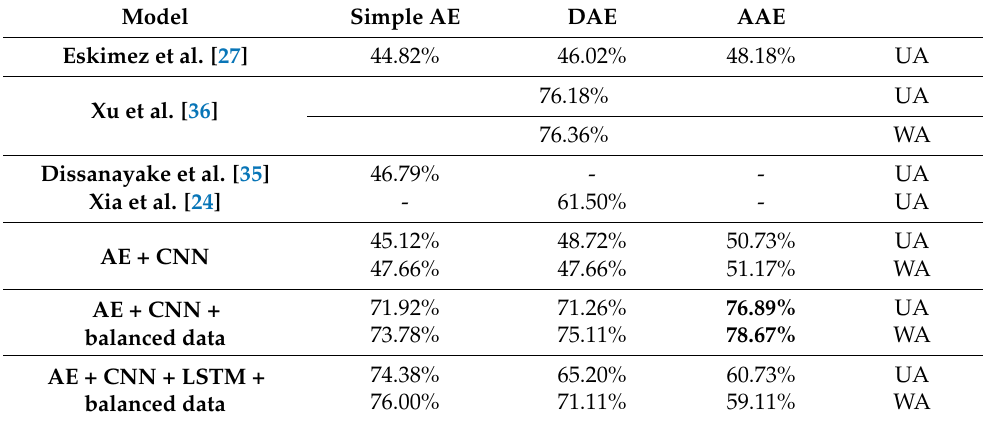
Table 6. Comparison of three models in classification with unweighted accuracy.